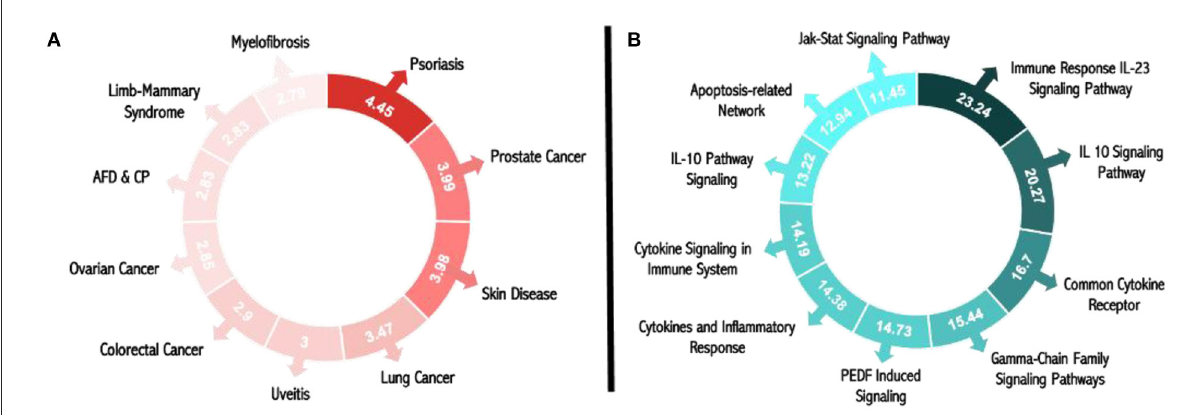
FIGURE4 Matching scores for miR-203 and its target genes in pathways and illnesses. (A) Pathway matching score for psoriasis and all research biomarkers. (B) Score for all the study biomarkers that match diseases.